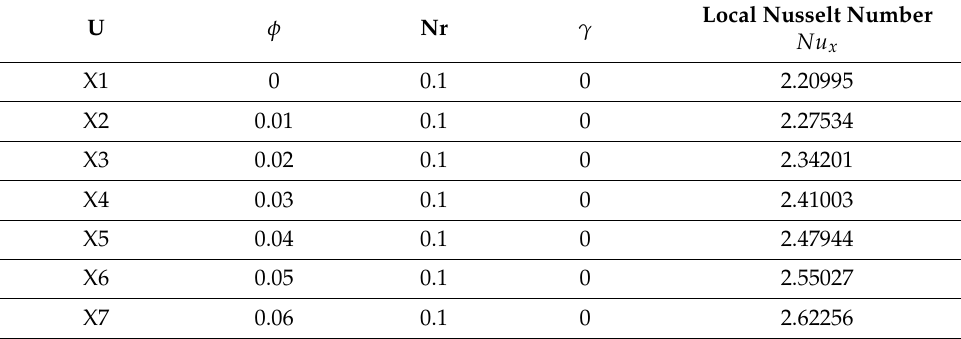
Table 1. Decision Table of local Nusselt number for various values of φ , Nr and γ